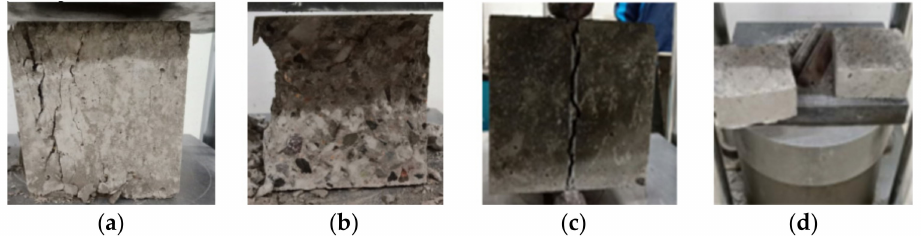
Figure 24. The damaged form of a concrete test block mixed with coal gangue and plant fibers [112]: ( a ) Add plant fiber cube; ( b ) No plant fiber cube compression; ( c ) Add plant fiber cube split; ( d ) No plant fiber cube